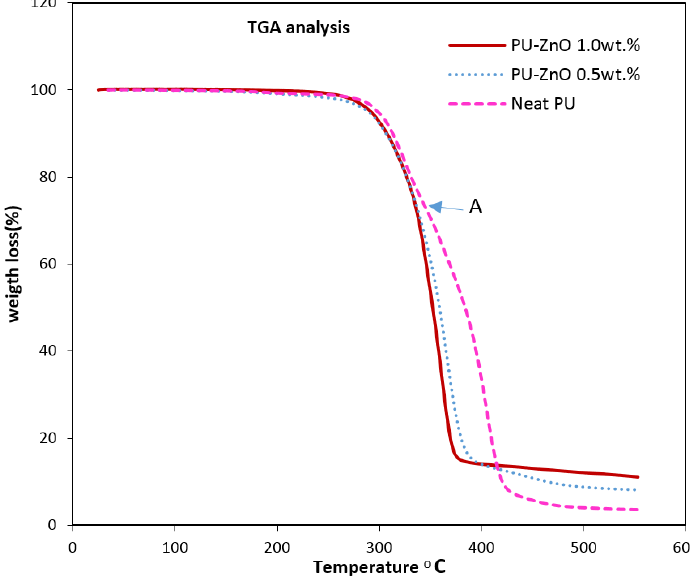
Figure 4. TGA analysis of PU and PU ‐ ZnO MMMs.